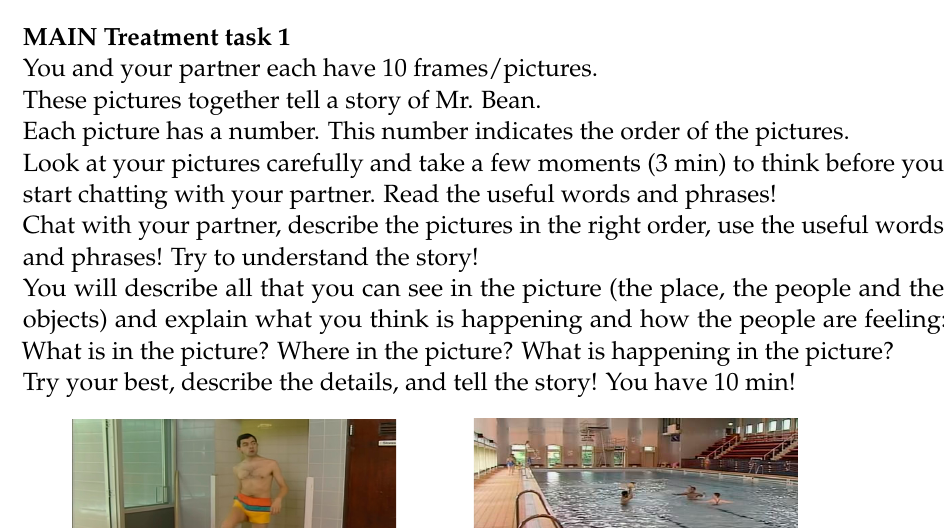
vocabulary activity. lary